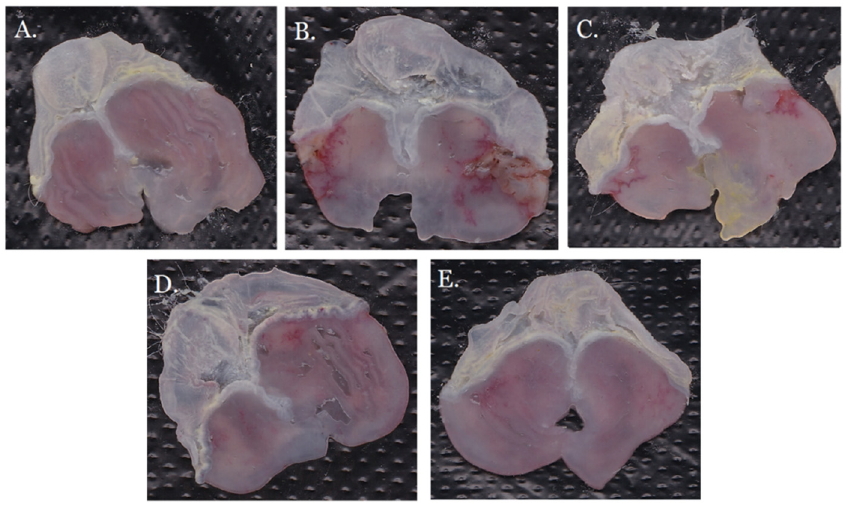
Figure 6. Gastric mucosal injury of mouse in ( A ) control group, ( B ) model group, ( C ) GRR-CDs high-dose group, ( D ) GRR-CDs medium-dose group and ( E ) GRR-CDs low-dose